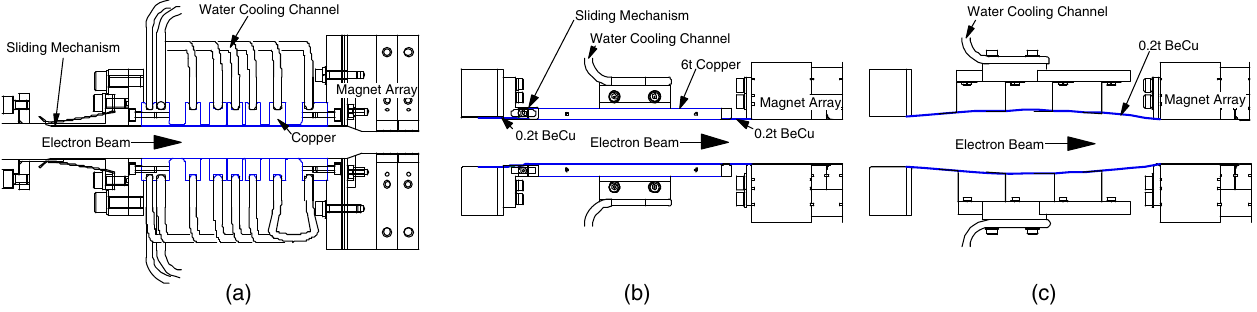
FIG. 2. Sketch of different designs for the transition taper: (a) cellular radiator type (similar to that used in SLS), (b) drawbridge type (TPS) and (c) thin BeCu type (similar to that used in SPring-8).